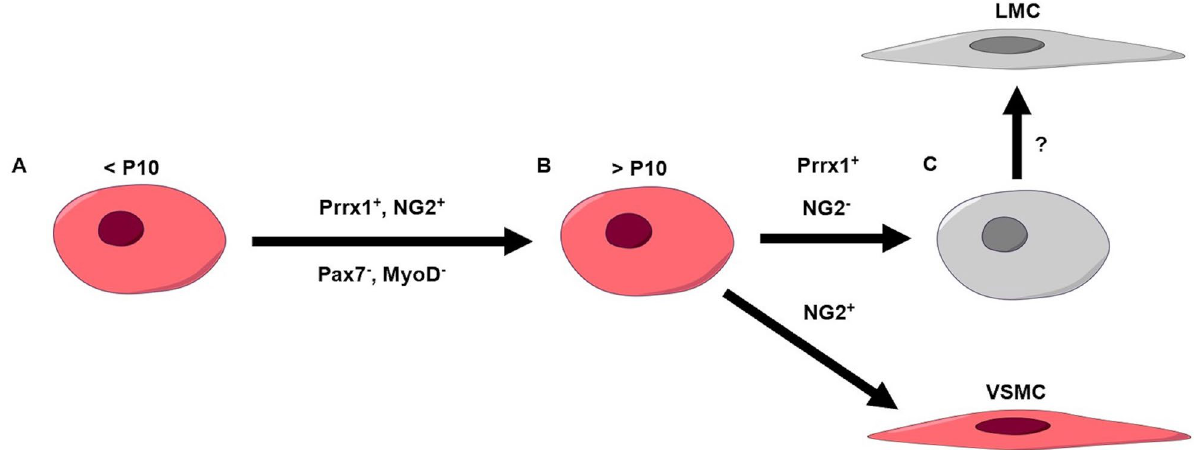
Figure 5. Neonatal PLV-LMC progenitor cell pathways. Prior to P10, LMCs derive from a Pax7 − /MyoD − / Prrx1 + /NG2 + progenitor similar to VSMCs ( A ). Between P10 and P21, newly incorporating PLV-LMCs diverge from the similar Prrx1 + /NG2 + VSMC progenitor pathway and derive from distinct Prrx1 + /NG2 − progenitors ( B ). These Prrx1 + /NG2 − PLV-LMC progenitors likely utilize currently unknown transcriptional switches to specify their incorporation to the PLV ( C